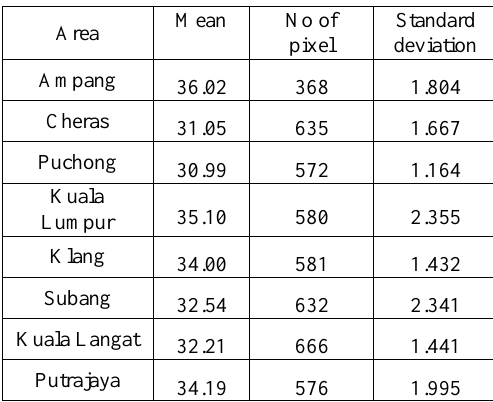
Table 4. The mean temperatures for each sampled areas